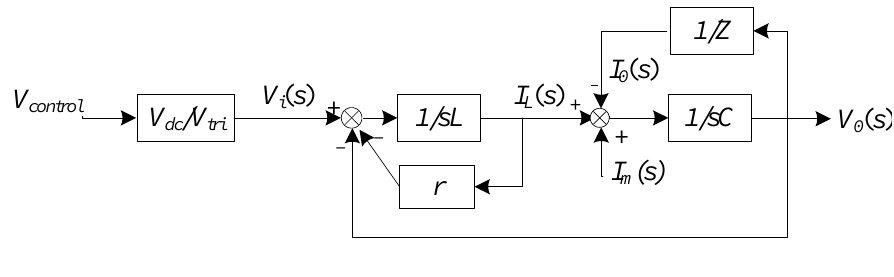
Figure 3. Equivalent dynamic